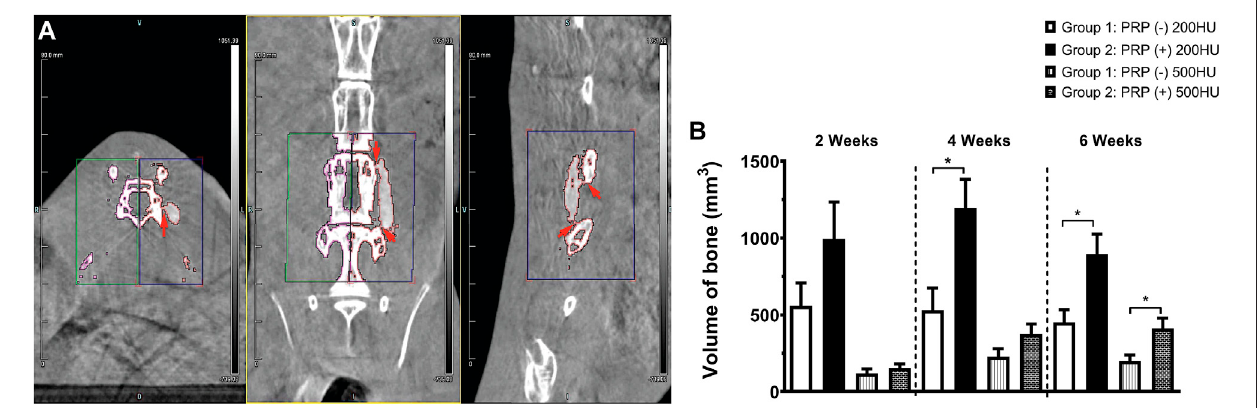
FIGURE 5 | Volumetric quanti fi cation of osteogenesis. Areas of bridging bone and fusion (arrowheads) were clearly appreciated on axial, coronal, and sagittal CT views where identically sized ROI ’ s were selected (A) on the experimental right and control left sides for volumetric new bone quanti fi cation. Newly formed trabecular (200HU) and cortical (500HU) bone was quanti fi ed and compared between the two experimental groups over time (B) , * p < 0.05.